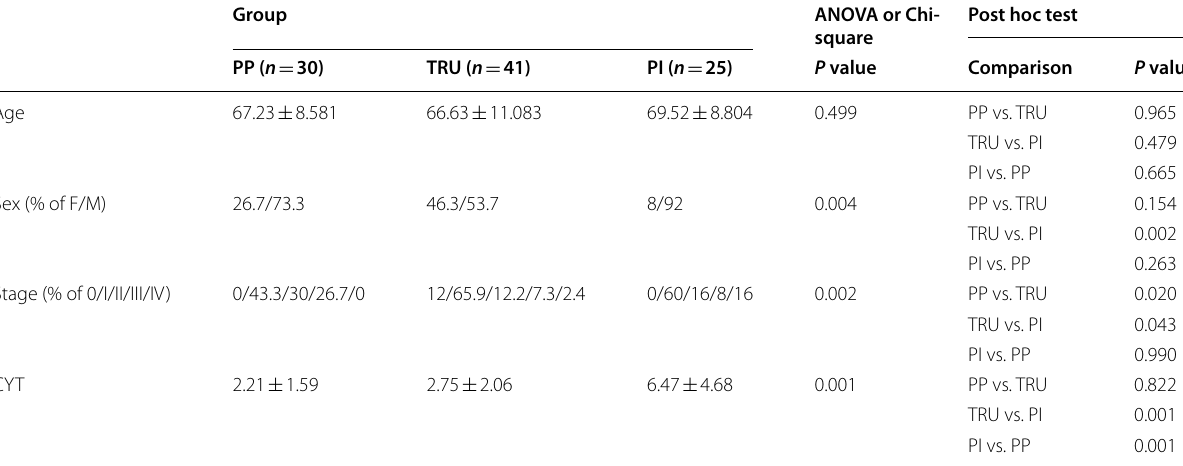
TRU terminal respiratory unit, PP proximal proliferative, PI proximal inflammatory, CYT cytolytic